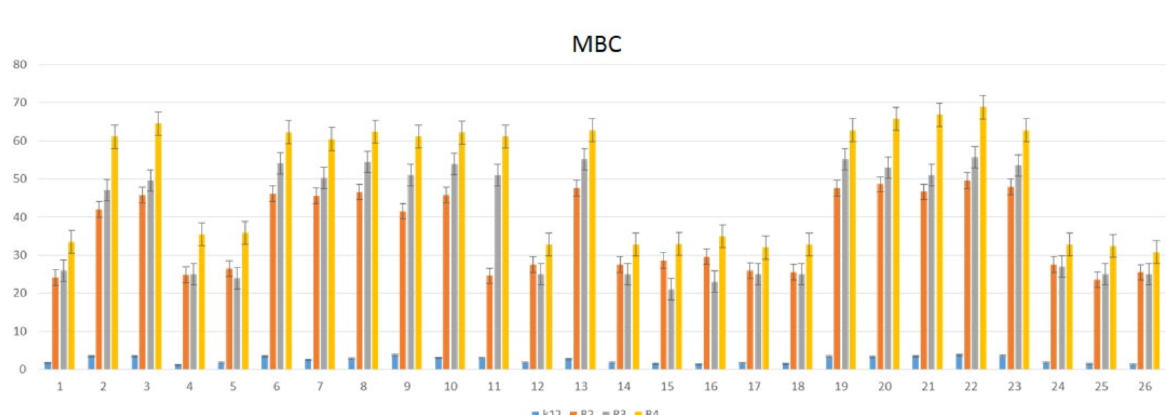
Figure 4. MBC of the amidoxime derivatives 1 – 26 in model bacterial strains. On the x -axis, 26 compounds were used sequentially. The y -axis shows the MBC value in µ g/mL − 1 (see Supplementary Materials). Each experiment was performed independently in 3 replications ( n =